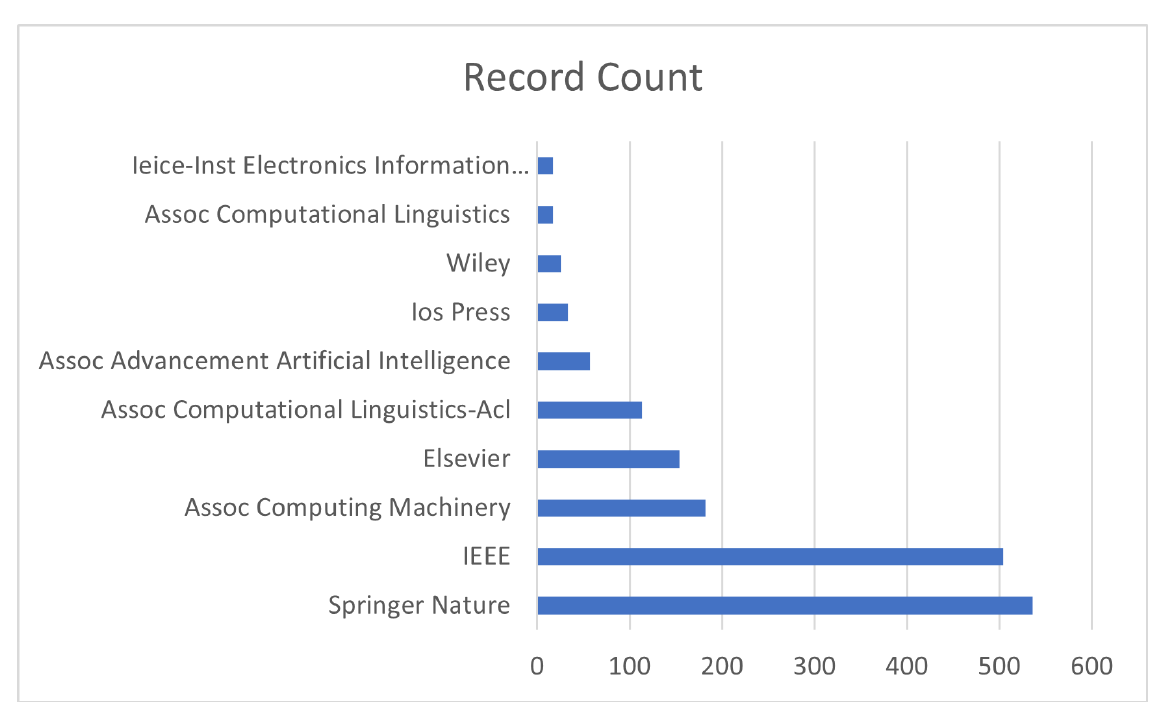
Figure 9. Top Publishers